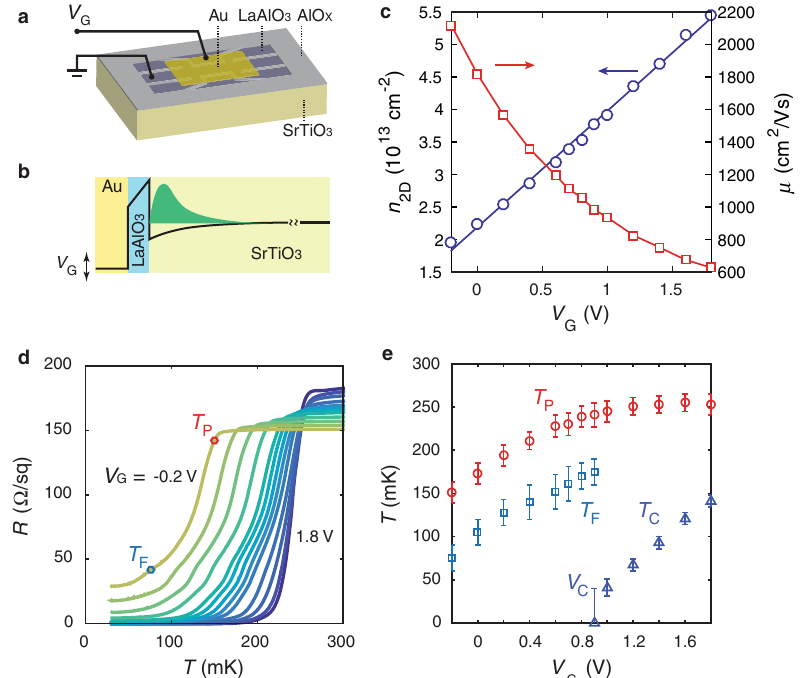
Fig. 1 Resistivity-versus-temperature ( R-T ) characterization of the gated LaAlO 3 /SrTiO 3 interface. a Schematic of a Au top-gated LaAlO 3 / SrTiO 3 device. 9 unit cells of epitaxial LaAlO 3 is grown by pulsed laser deposition on top of SrTiO 3 substrate with pre-patterned AlO x hard mask. Channel width is 400 micrometers. b Schematic diagram for the electrons con fi ned at the interface with density tunable by the top gold gate. The black solid line represents the conduction band bottom. The green shade represents the electron density distribution of the con fi ned electrons. c Gate modulation of carrier density (circles) and mobility (squares) at T = 5 K. The blue solid line is a linear fi t to the circles. Red solid curve is a guide to the eyes. d R – T curves as V G is tuned from – 0.2 V to 1.8 V. Red and blue circles show examples on one curve for the characteristic temperature scales T P and T F (extracted from the peaks of the second derivatives - d 2 R / dT 2 ), respectively. e T P , T F , and T C as functions of V G . Navy triangles, blue squares, and red circles represent T C , T F , and T P , respectively. The critical voltage V C is determined by the intersection when extrapolating T C to zero. Error bars for T P and T F are determined based on width of the peaks of second derivatives. Error bars for T C represent con fi dence intervals of fi tted results. All data in this fi gure are from Sample